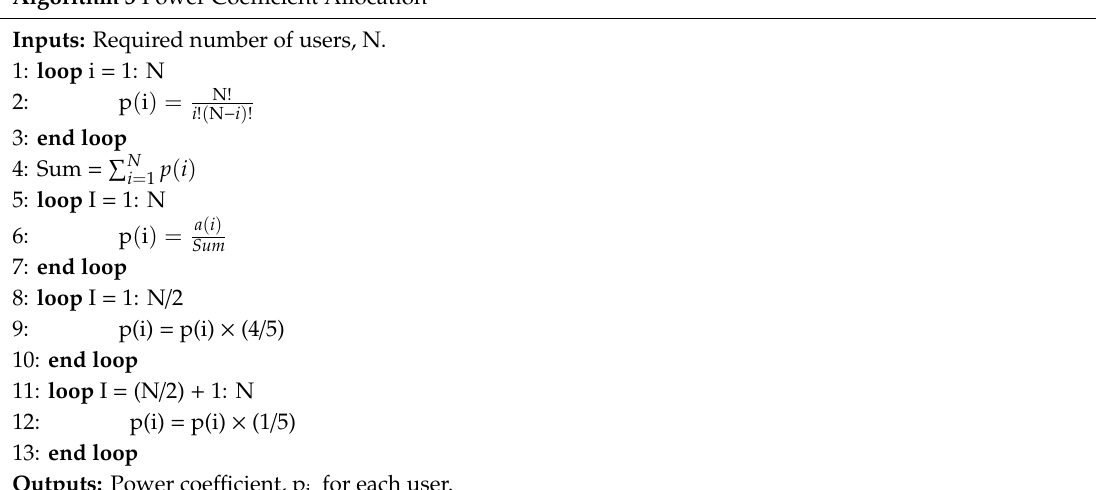
Algorithm 3 Power Coe ffi cient